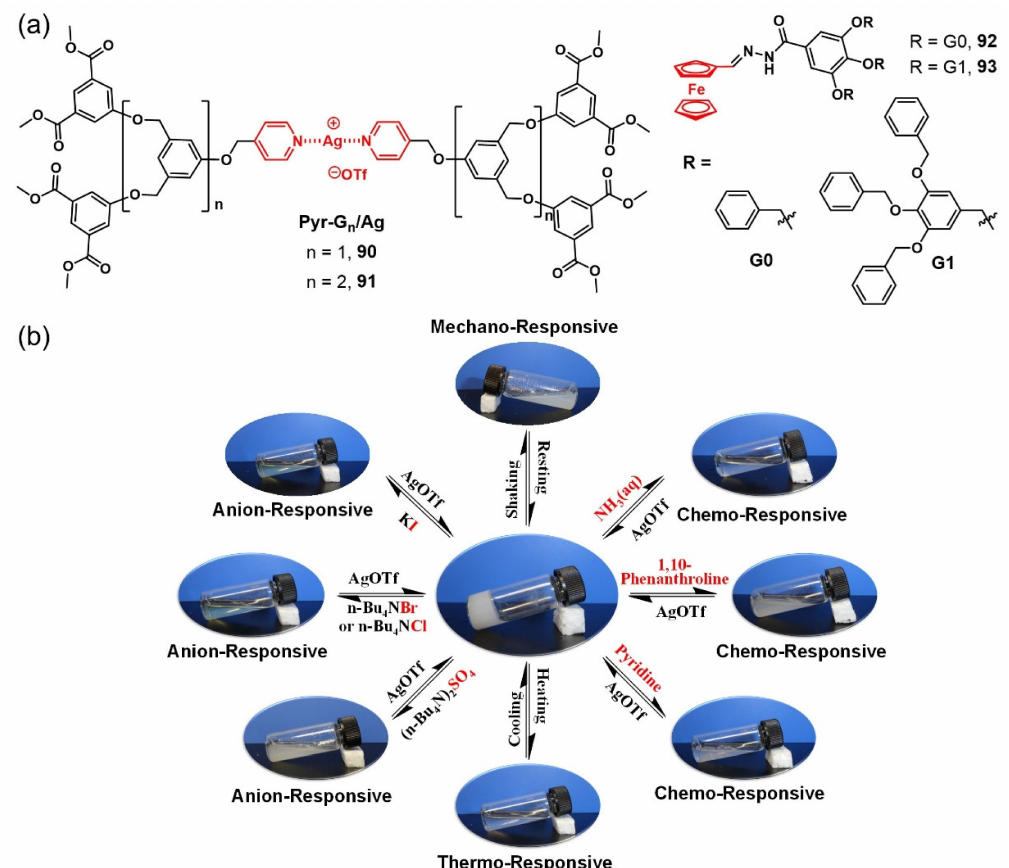
Figure 37. ( a ) Chemical structures of dendritic metallogelators 90 - 93 . ( b ) Reversible sol–gel phase transition of the metallogel triggered by shear stress, temperature and the presence of anions and chemicals. Reprinted with permission from Ref. [114]. Copyright (2014), John Wiley and